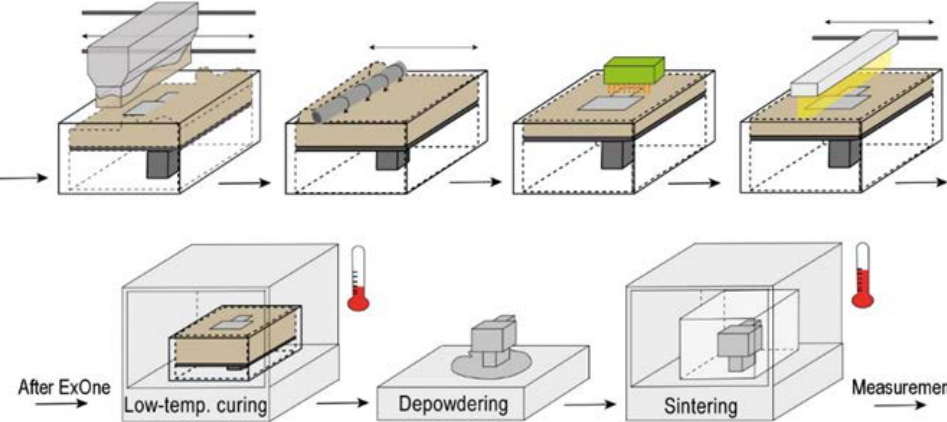
Figure 5. Schema of AM of piezoceramic samples based on BJ process.